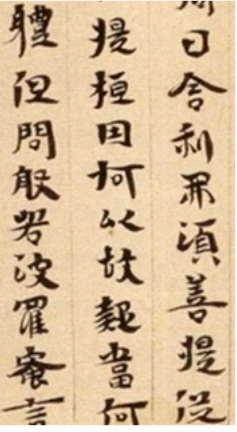
Figure 4. Ten Chants of Bhikkhu Precepts.